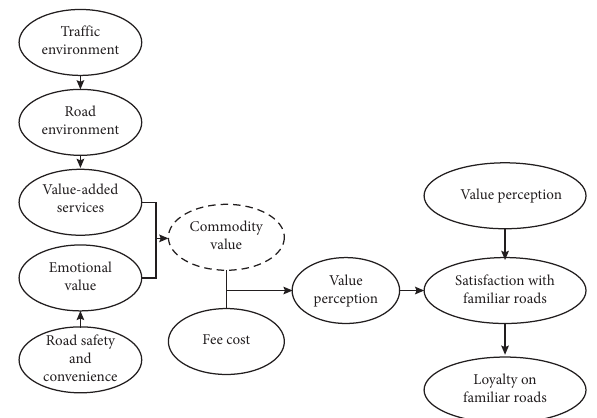
Figure 2: Structural model of truckers’ loyalty to familiar